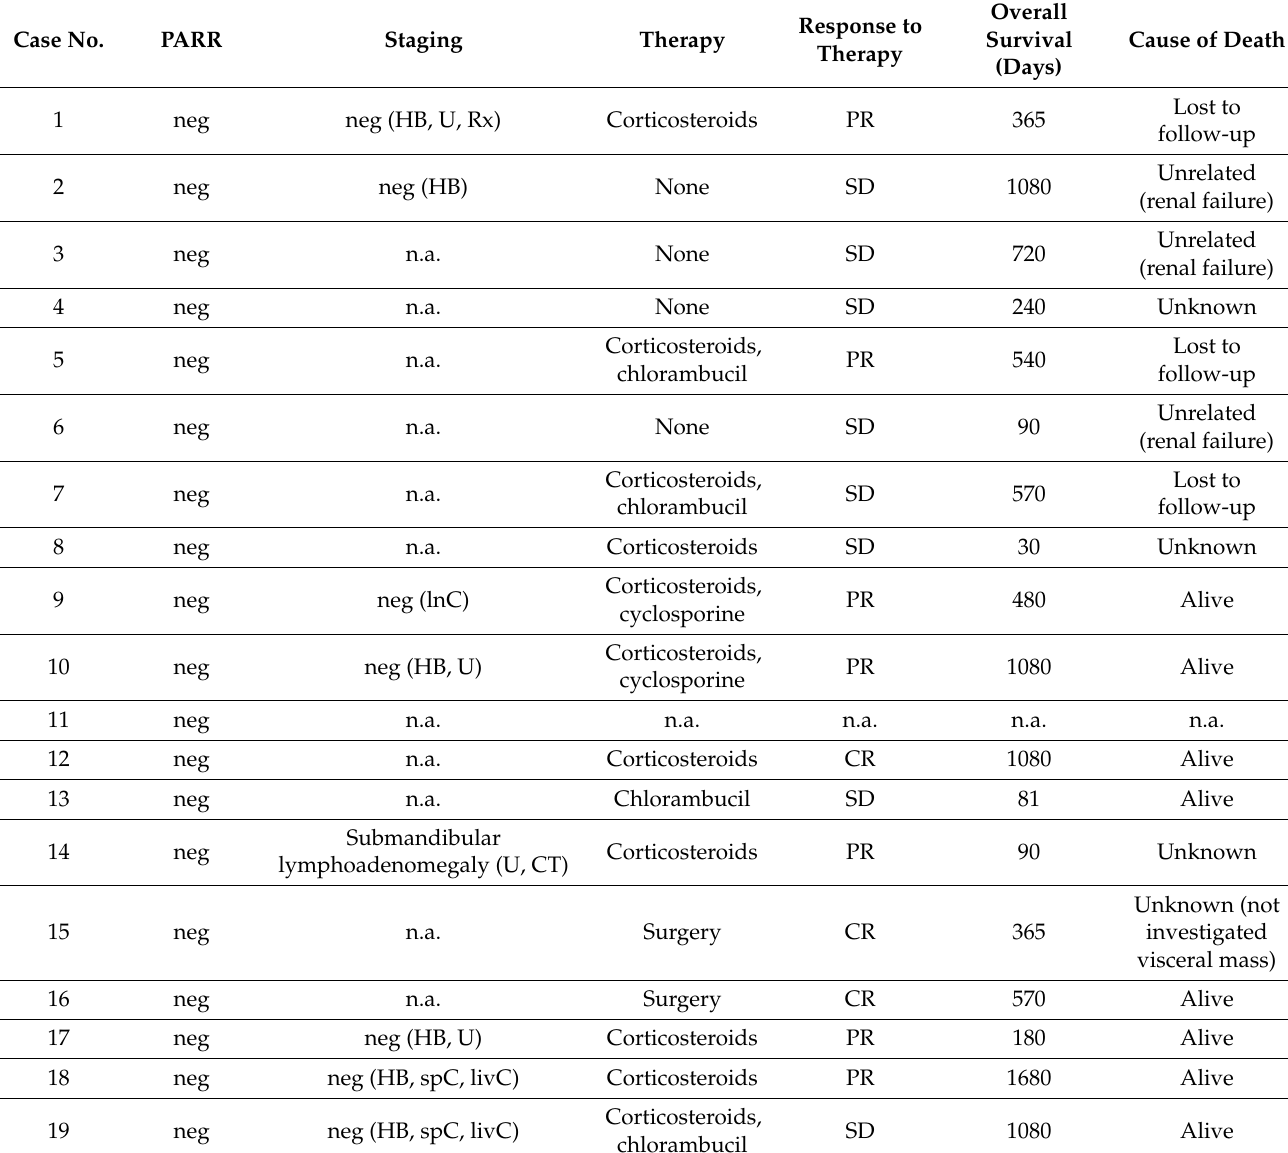
Table 3. Data on clonality testing (PARR), staging, therapy, response to therapy, overall survival, and cause of death in cats with cutaneous